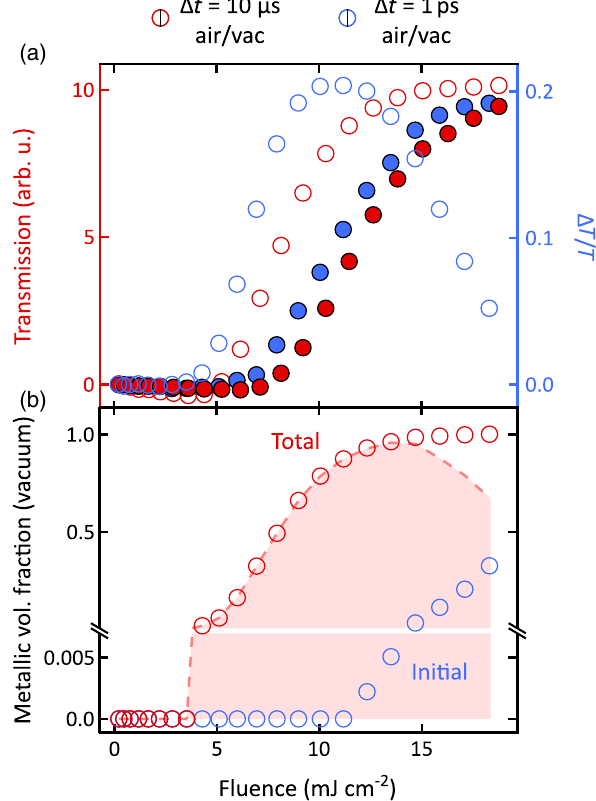
FIG. 2. (a) Fluence dependence transmission of the free- standing thin film of VO 2 in the microsecond (red) and femto- second (blue) regimes, measured both at atmospheric pressure (filled) and in vacuum (empty). The shift in threshold fluence due to vacuum demonstrates that accumulated heat strongly modifies the perceived threshold fluence. (b) Volume fraction of the rutile R phase as a function of temperature for the sample in vacuum. Red open circles correspond to the total volume fraction generated at the sample 10 - μ s after excitation. The blue open circles correspond to the volume fraction that existed before the pump pulse arrived. The dashed line is the difference between these data, and it corresponds to the pump-induced volume